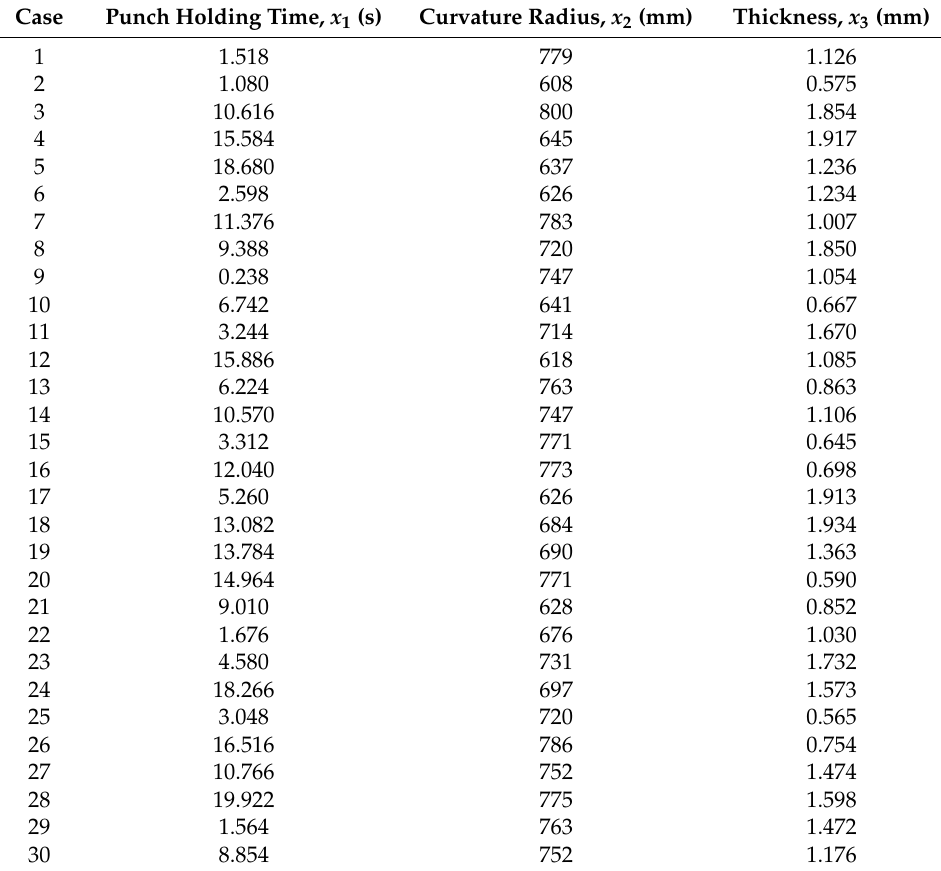
Table A2. Testing sample